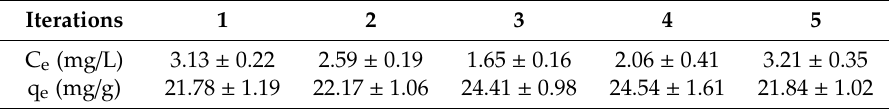
Table 5. Sorption–desorption cycles: sorption capacity and equilibrium concentration after each regenerating cycle, considering OSS dye (C 0 = 20 mg / L).